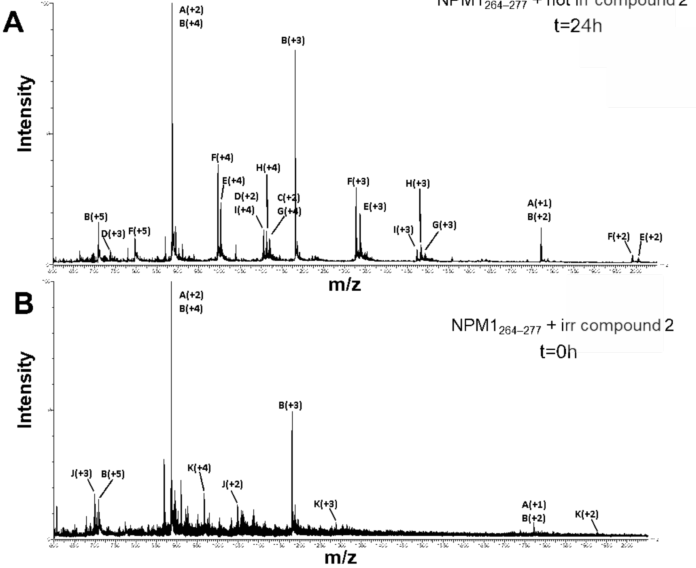
Figure 5. ESI-MS multi-charged spectra of NPM1 264–277 + compound 2 after 24 h of incubation (no irradiation) ( A ) and UV-irradiation upon freshly prepared sample ( B